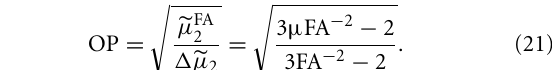
FIGURE 2 | Continued Equations (11) and (14). The dashed line corresponds to the isotropic DW with μ iso 2 = 0. (C) Relation between true μ FA values and their estimation from fitting Equation (25) to data generated in the same way as the data shown in panel (B) . Shown are the mean values (solid lines) and standard deviations (error bars) resulting from 1000 fitting iterations with synthetic noise corresponding to different SNRs [66]. (D) Relative systematic ( δ r , dashed line) and random errors ( ε r , solid lines) calculated from data shown in panel (C) . In panel (B) , the red, green, and blue colors correspond to different μ FA values, while in panels (C,D) , the colors correspond to different SNR